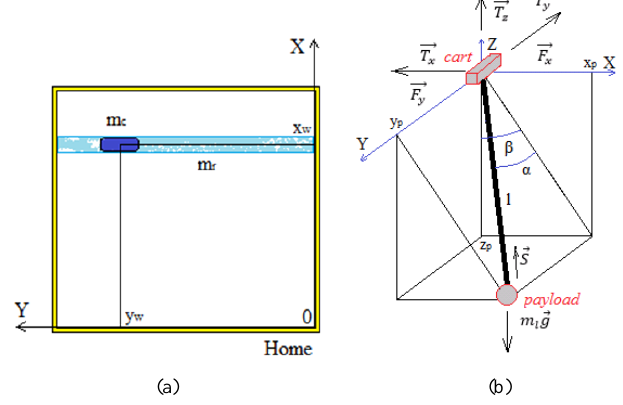
Fig. 2. 3D Crane: (a) workspace (b) schematic